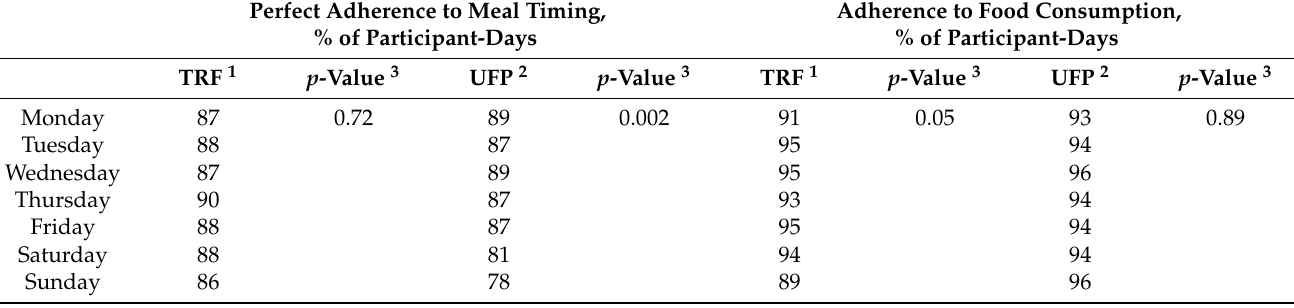
Table 4. Distribution of perfect adherence to meal timing and adherence to food consumption by day of